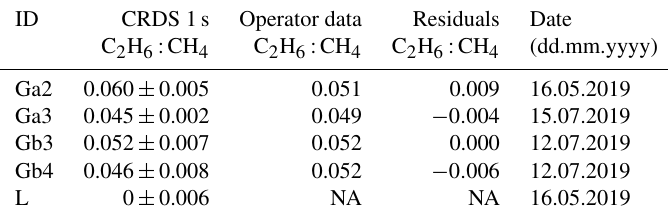
Table 7. Fieldwork. Comparison of results obtained by CRDS G2201-i with the values from the operator company. NA – no data are